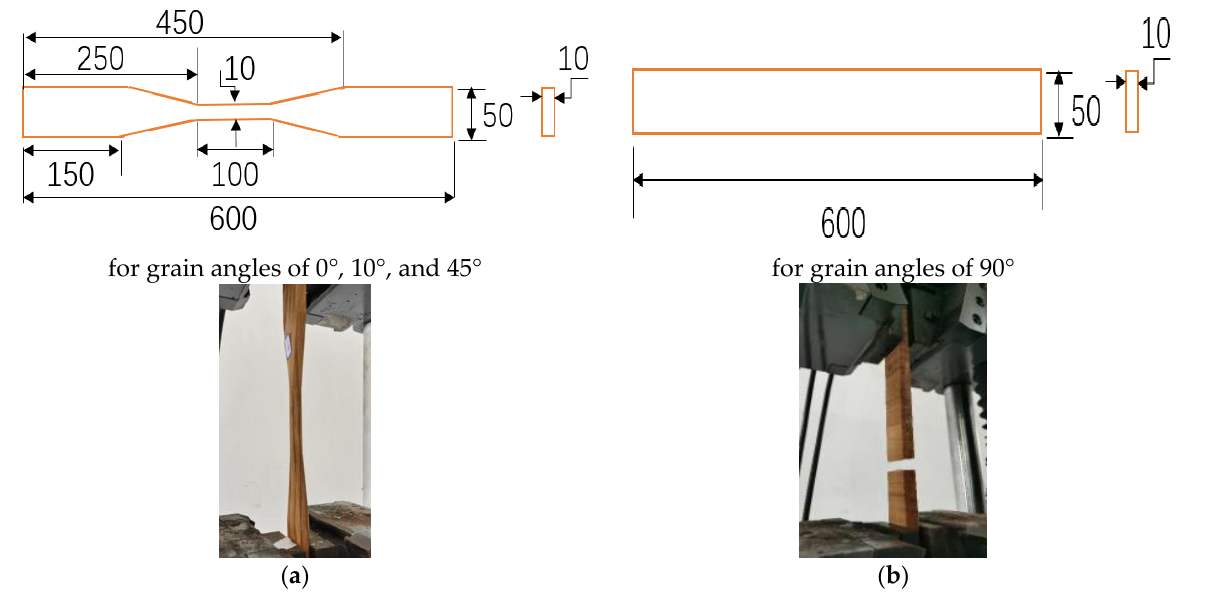
Figure 1. Dimensions of the samples: ( a ) sample dimension type for grain angles of 0°, 10°, or 45°; ( b ) sample dimension type for a grain angle of 90°.